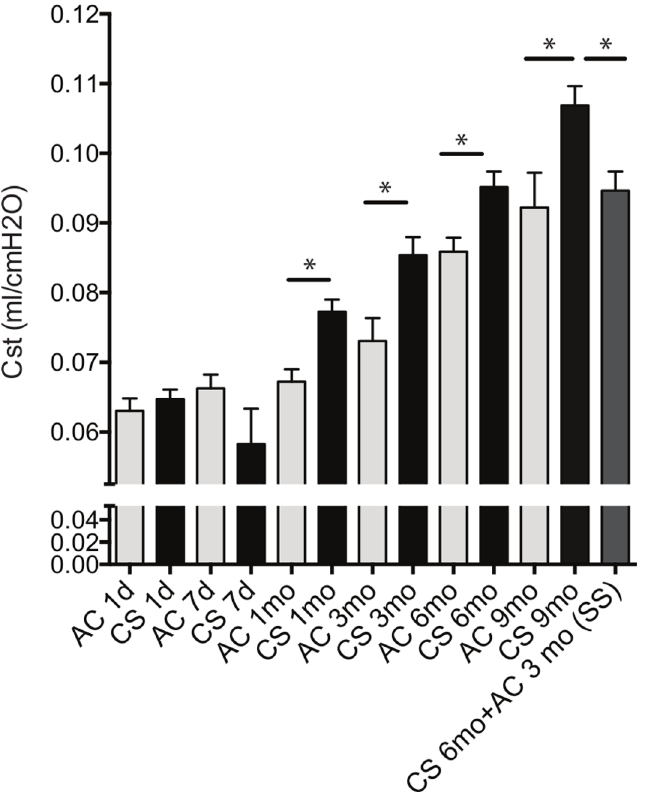
Fig 1. Mean static lung compliance (Cst). Cst measuredby the flexiVent ™ instrument for each experimental group at each time point. C57Bl/6 mice were exposed to ambient air (AC, grey bars) or chronic cigarette smoke (CS, black bars) for the indicateddurationof time measuredin days (d) or months (mo). In one group of mice that underwentsmoking cessation (SS; stop smoking, dark grey bar), mice were allowedto recover at ambientair (AC) for 3 months followinga 6 months CS exposure. N = 10 mice /group. Horizontal bars with asterisk indicatesignificantdifferencesin mean static lung compliance( p < 0.05). Bars represent the standarderror of the